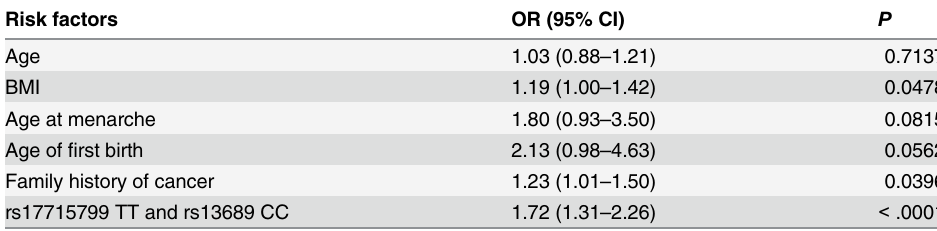
Table 4. Multiple logistic regression analysis of the major risk factors for